Question: Express in one sentence what the figure is showing.
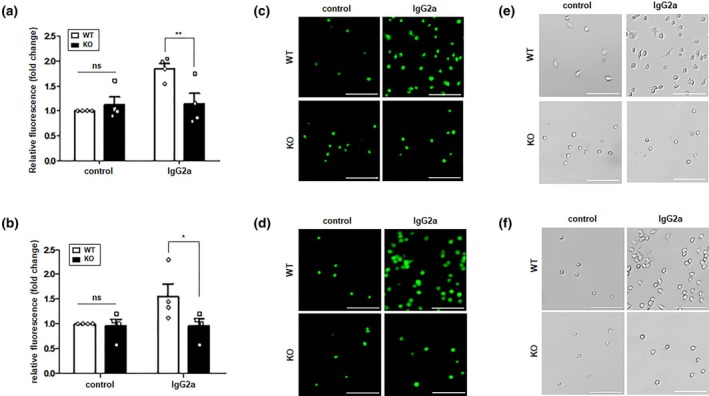
Answer: Adhesion defects in ARAP‐KO BMDCs. Calcein‐labeled WT and ARAP‐KO BMDCs were either left unstimulated (control) or FcγR‐stimulated (IgG2a) at 37°C for 30 min. Cells were seeded into the wells of a plate coated with fibronectin (a, c, e) or ICAM‐1‐Fc (b, d, f) . (a, b) Fluorescence intensity correlates with the number of adherent calcein‐labeled cells and is presented as relative values normalized to unstimulated WT BMDCs. Each individual dot represents the mean of technical triplicates from one independent experiment, and the data shown are compiled from multiple independent experiments. The data are presented as the mean ± s.e.m. Statistical significance was analyzed by two‐way ANOVA with Bonferroni's post hoc tests (* P < 0.05, ** P < 0.01; ns, no significance). (c, d) The adherent cells after 2 h of incubation at 37°C were analyzed by microscopy. Representative fluorescence images are provided to qualitatively support the adhesion phenotype. Scale bars = 100 μm. (e, f) Bright‐field images of the same samples showing morphological changes after FcγR stimulation. Representative images are shown. Scale bars = 100 μm.